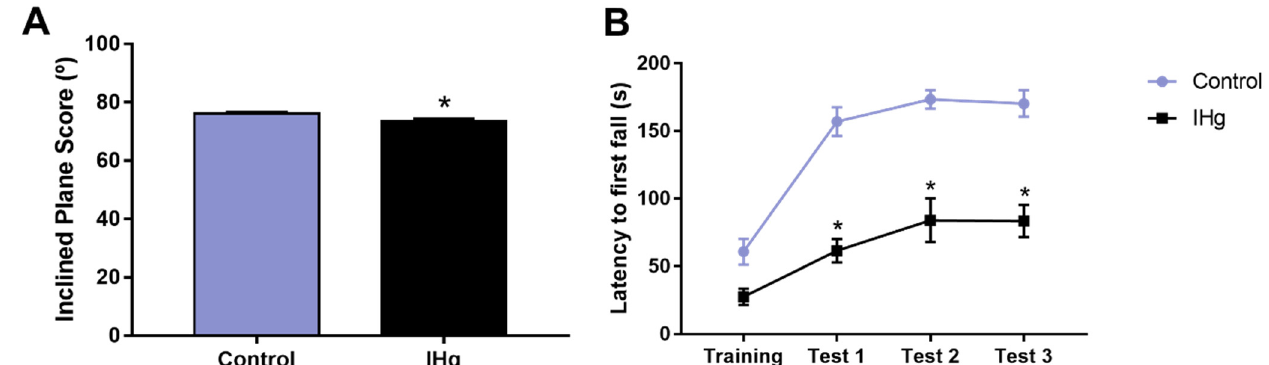
Figure 7. Inclined plane and rotarod performances of rats exposed to 0.375 mg/kg of HgCl 2 for 45 days. In ( A ), an average of the falling degree of five test sessions in inclined plane. In ( B ), latency (seconds) to the first fall in rotarod. Results are expressed as mean ± S.E.M. * p < 0.05, t-Student test ( A ) or one-way ANOVA with repeated measures ( B ) (n = 20).